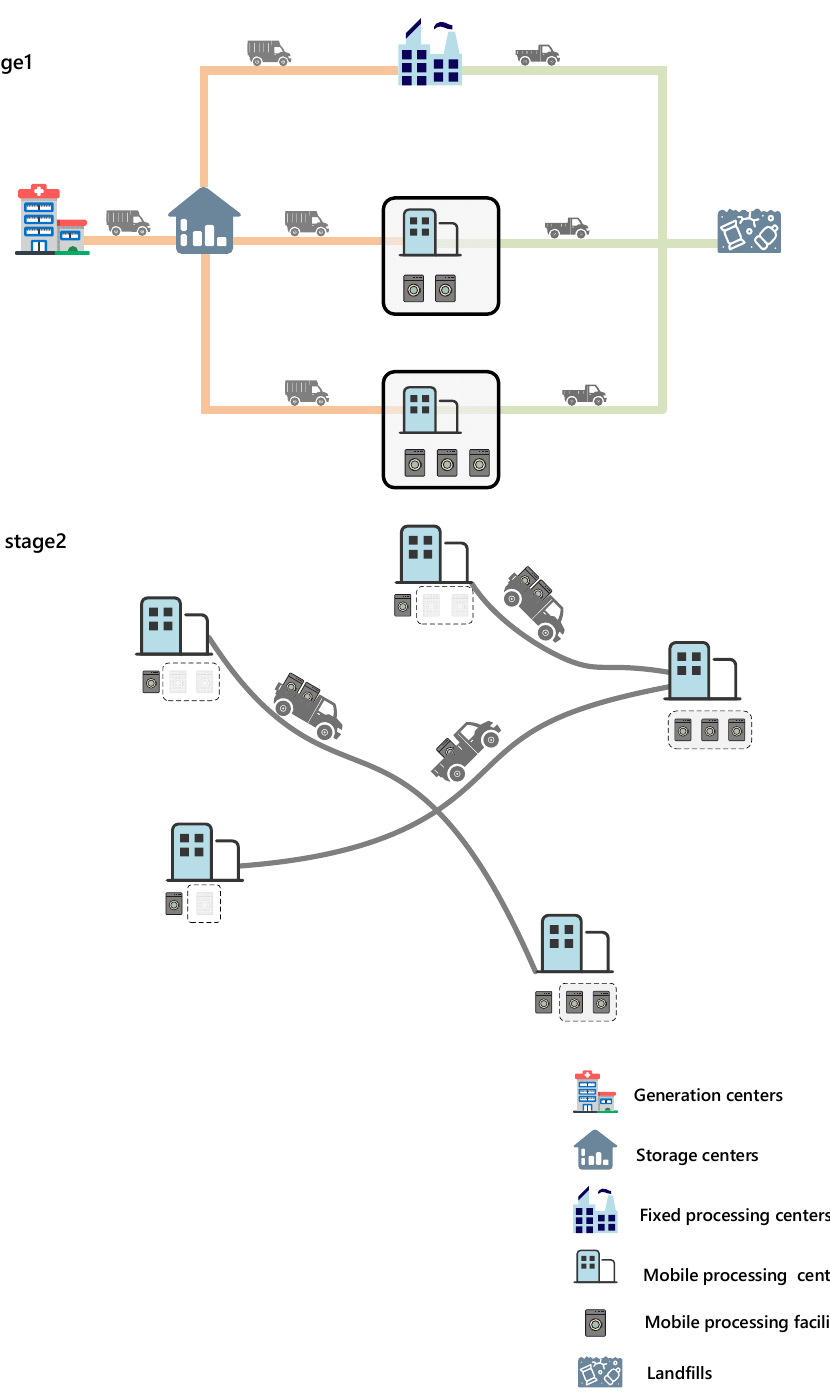
Figure 2. The structure of the proposed network.